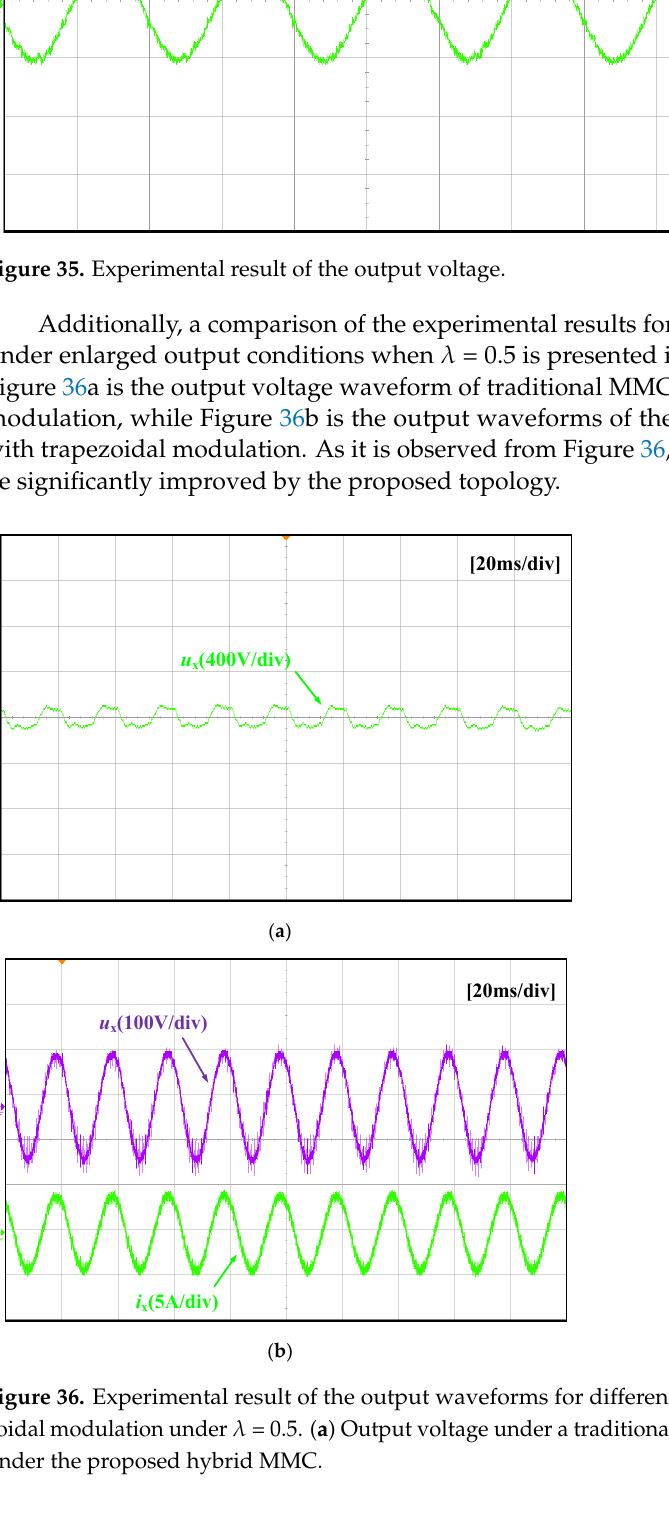
Figure 36. Experimental result of the output waveforms for different MMC topologies with trape- zoidal modulation under λ = 0.5. ( a ) Output voltage under a traditional MMC. ( b ) Output waveforms under the proposed hybrid MMC.